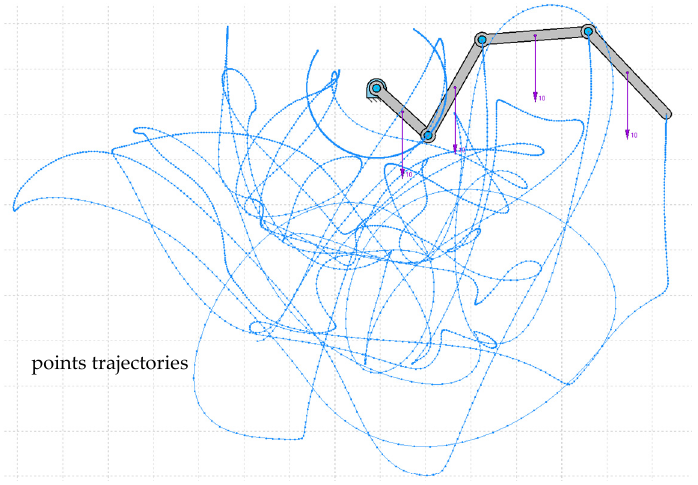
Figure 16. Simulating the motion of a chain released to the effect of gravity from repose.